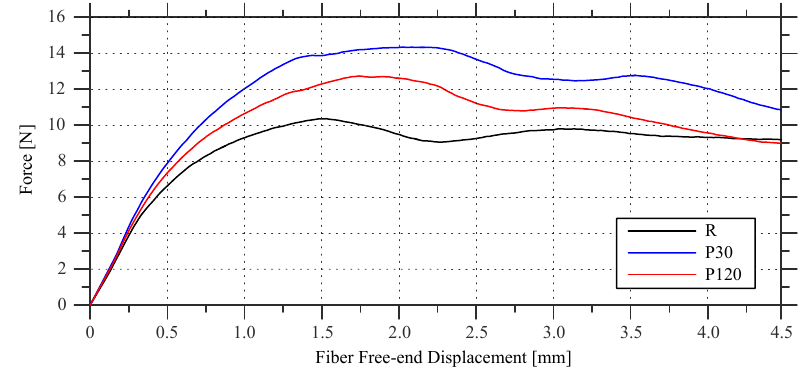
Figure 1. Pull-out behavior of reference and modified fibers.